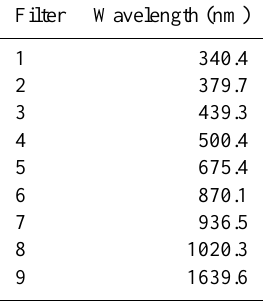
Table 2. Measuring wavelengths of Cimel #395. The nominal reso- lution is 10nm (FWHM) for each